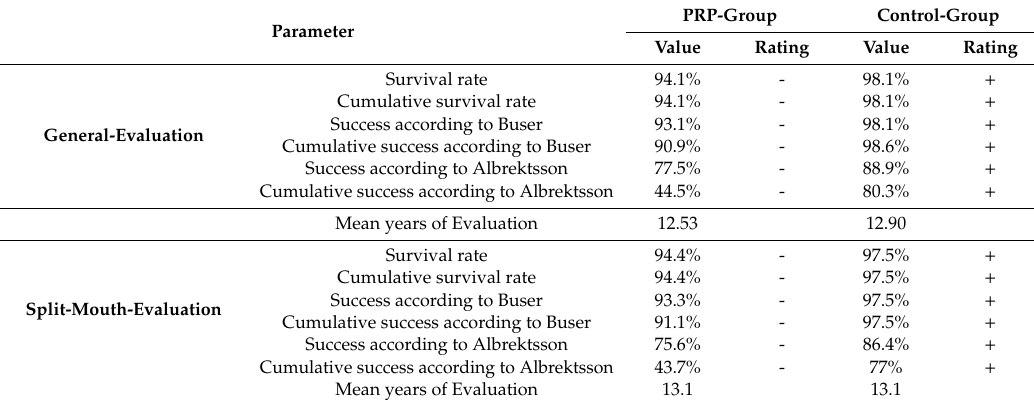
Table 1. Summary of test results and comparison of PRP and control group based on tested